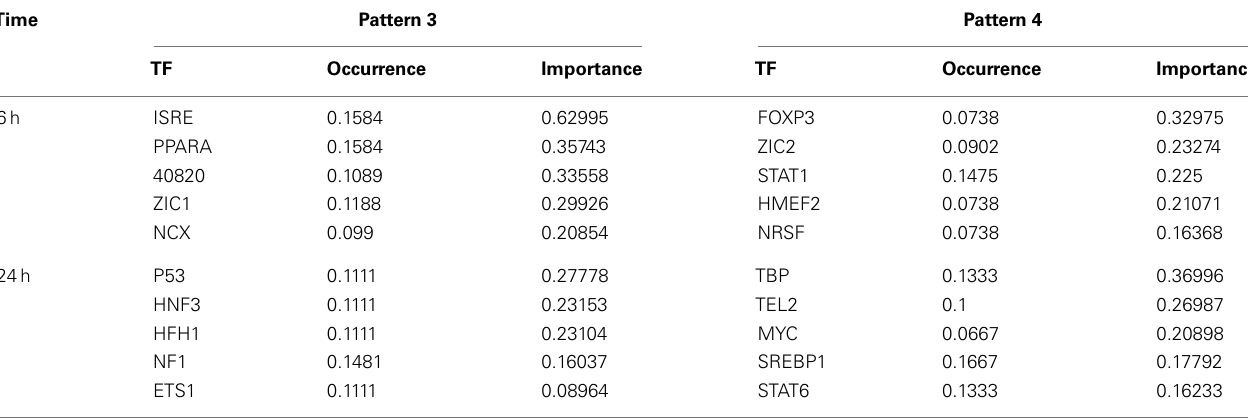
Table 2 |Transcription factors for co-regulated genes from pattern 3 and 4 at 6 and 24h postAPAP treatment.